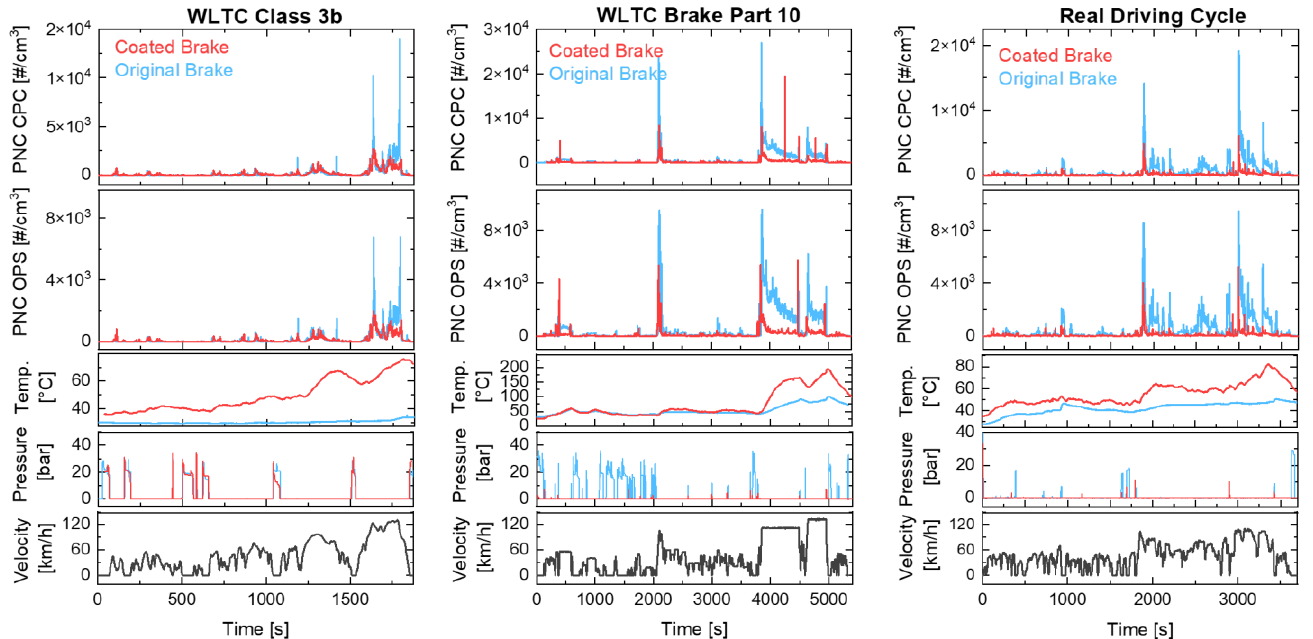
Figure 7. Comparison of airborne particle emissions for three driving cycles with the original and a coated brake disc. Ultrafine/fine particle number concentrations for particle diameters between 4 nm and 3 μm and coarse particles between 300 nm and 10 μm, measured by the CPC and OPS, respectively. Vehicle and brake parameters included the velocity of the vehicle, pressure of the hydraulic brake, and brake temperature.